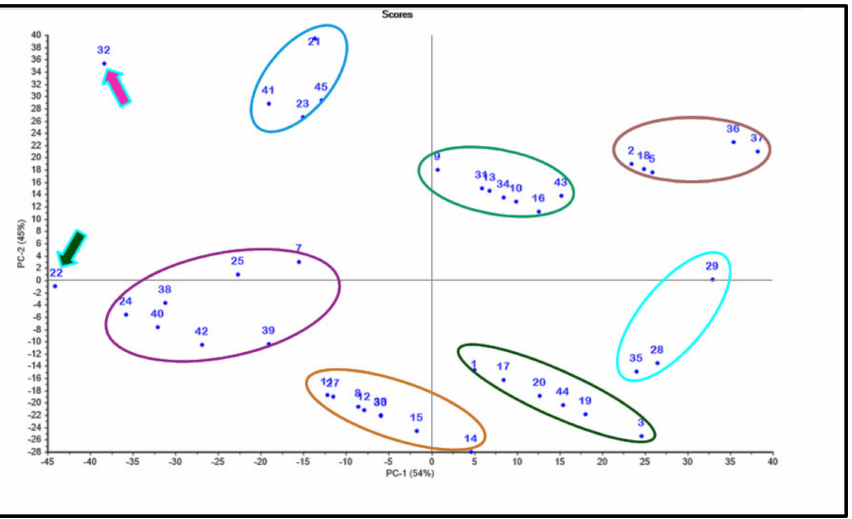
Figure 5. PCA score plot of different cannabinoids using a chemometric unsupervised pattern recognition technique; compounds are given numbers as listed in Table